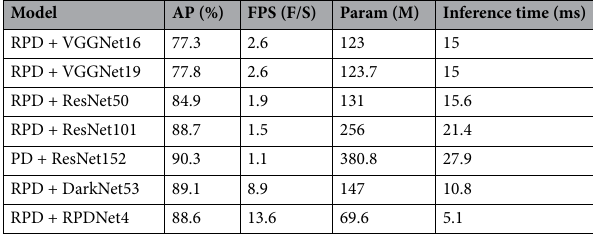
Table 2. Comparison of results of ablation